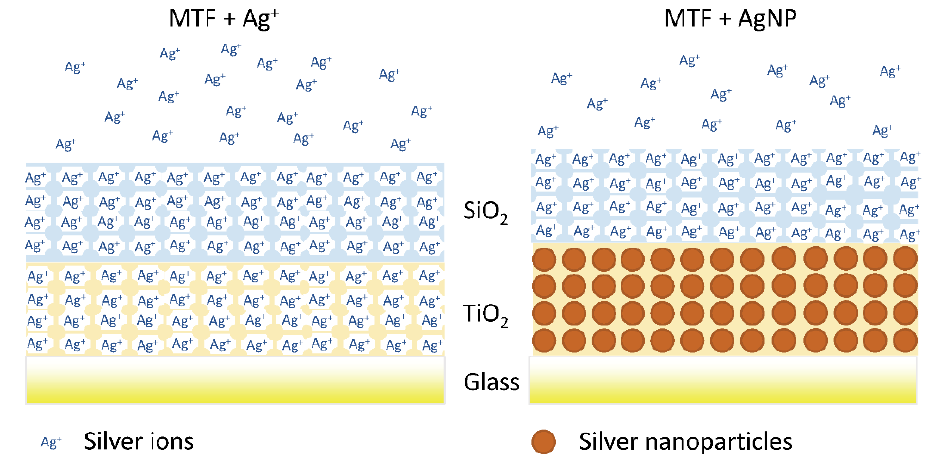
Figure 4. Scheme of the silver loaded silica-titania thin film ( left ) and of the film with silver nanoparticles embedded in the lower TiO 2 layer, covered by the silica layer with Ag + adsorbed ( right ). Reproduced from P.N. Catalano et al., Microporous and Mesoporous Materials 236 (2016), with permission from Elsevier.